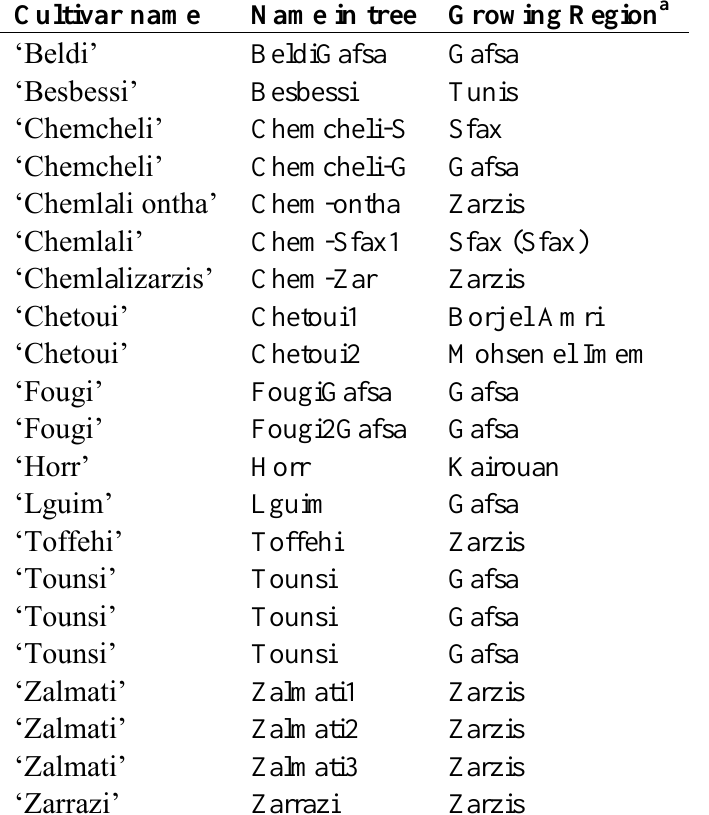
Table 3. List of the olive accessions analyzed from the Tunisian olive germplasm